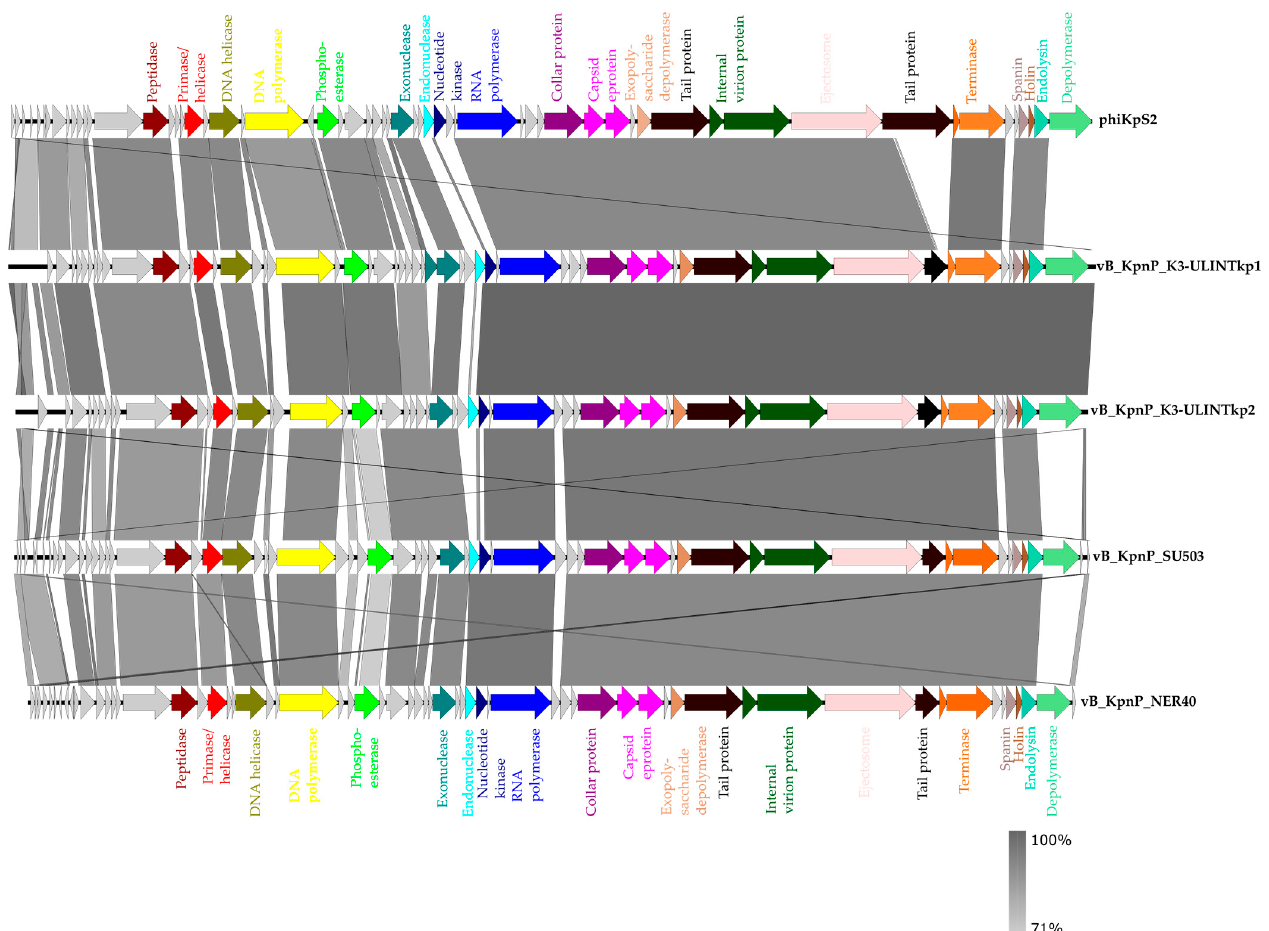
Figure 2. Comparative genomics of bacteriophages vB_KpnP_K3-ULINTkp1 and vB_KpnP_K3- ULINTkp2 with bacteriophages phiKpS2, vB_KpnP_SU503, and vB_KpnP_NER40.